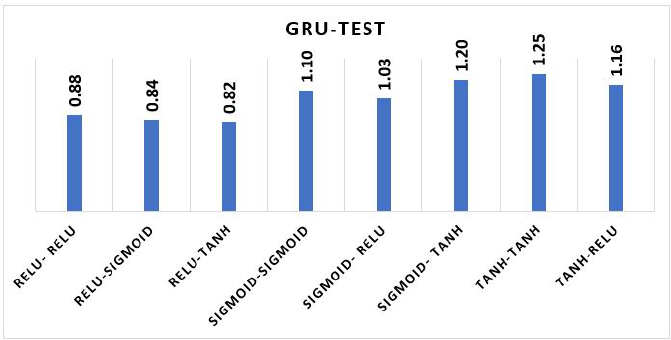
Figure 18. Average RMSE values, different types of activation